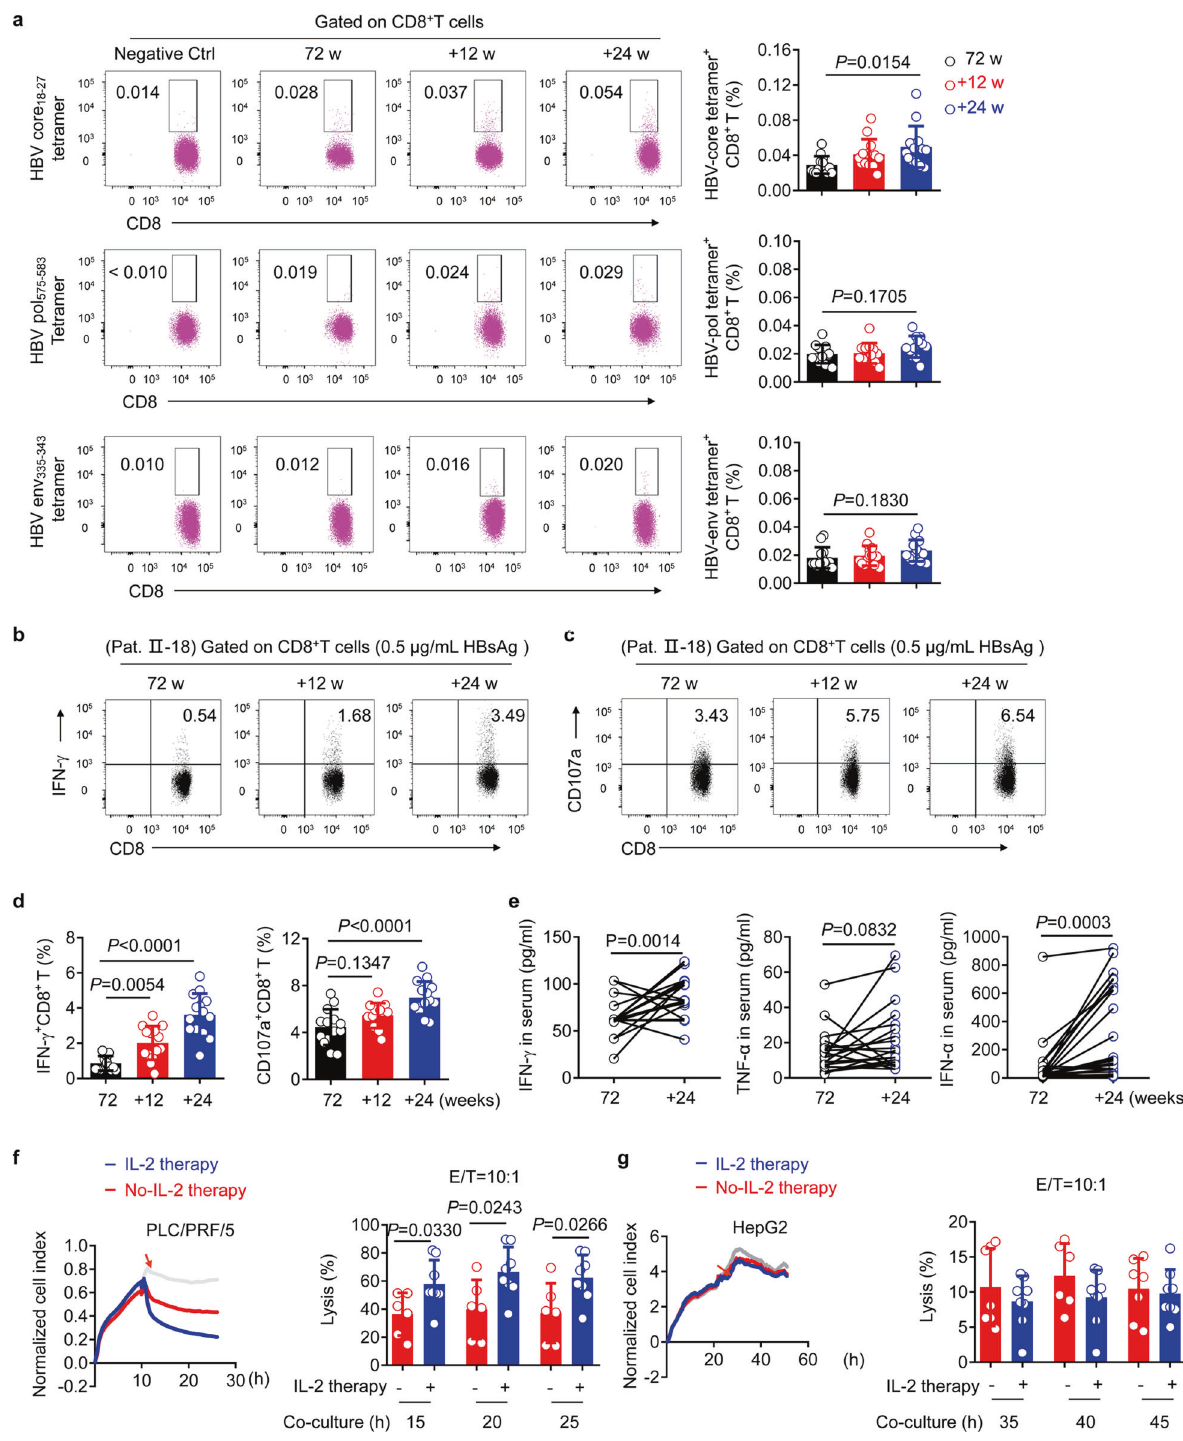
in restoring the immune response and promoting the loss of HBeAg. Collectively, our fi ndings make three important con- tributions to elucidating the underlying mechanisms and explaining the observed clinical outcomes following sequential IL-2 treatment. First, we demonstrated the limited ef fi cacy of IFN- α therapy and describe the rationale for the use of IL-2. Evaluation of 92 patients with CHB who had been treated with Peg-IFN- α -2b for 48 weeks revealed that approximately 70% were non-responders,